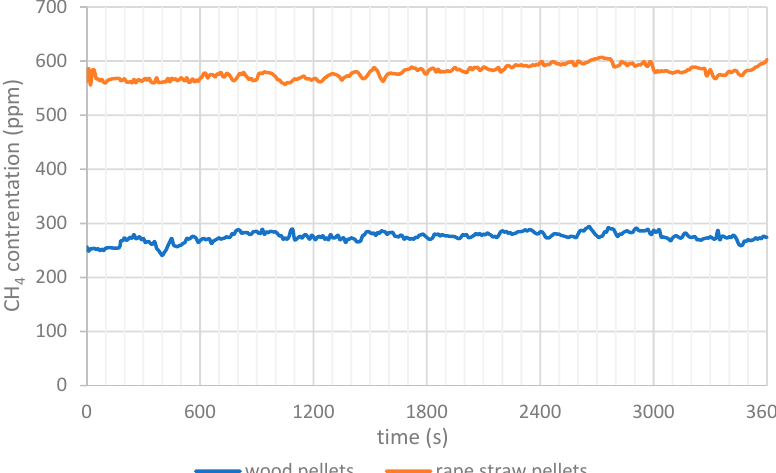
Figure 4. Time course of changes in CH 4 concentration for combustion tests of wood pellets and rape straw pellets.